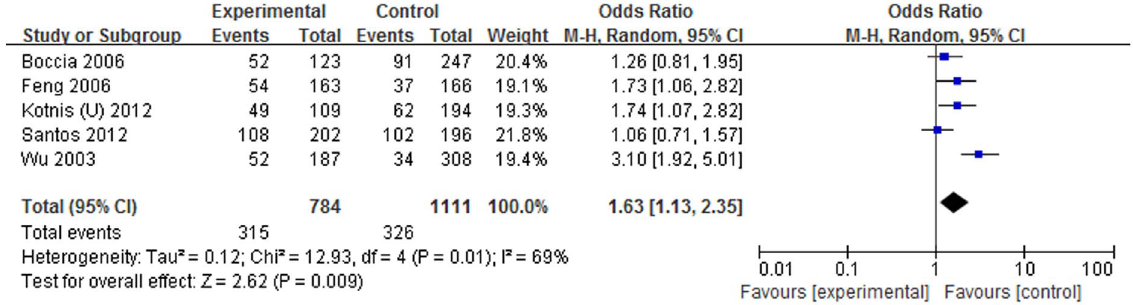
Figure 3. Forest plot on the association between SULT1A1 Arg213His polymorphism and UADT cancer risk in dominant model.